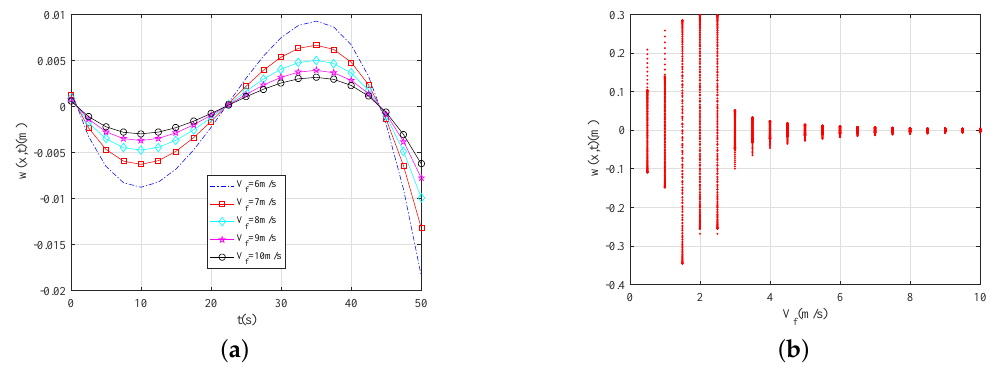
Figure 4. Dynamic response with the fluid velocity varying when n values 4 and x values 1 m within 50 s for ( a ) displacement response of w ( x , t ) and ( b ) displacement oscillation of w ( x , t ) .